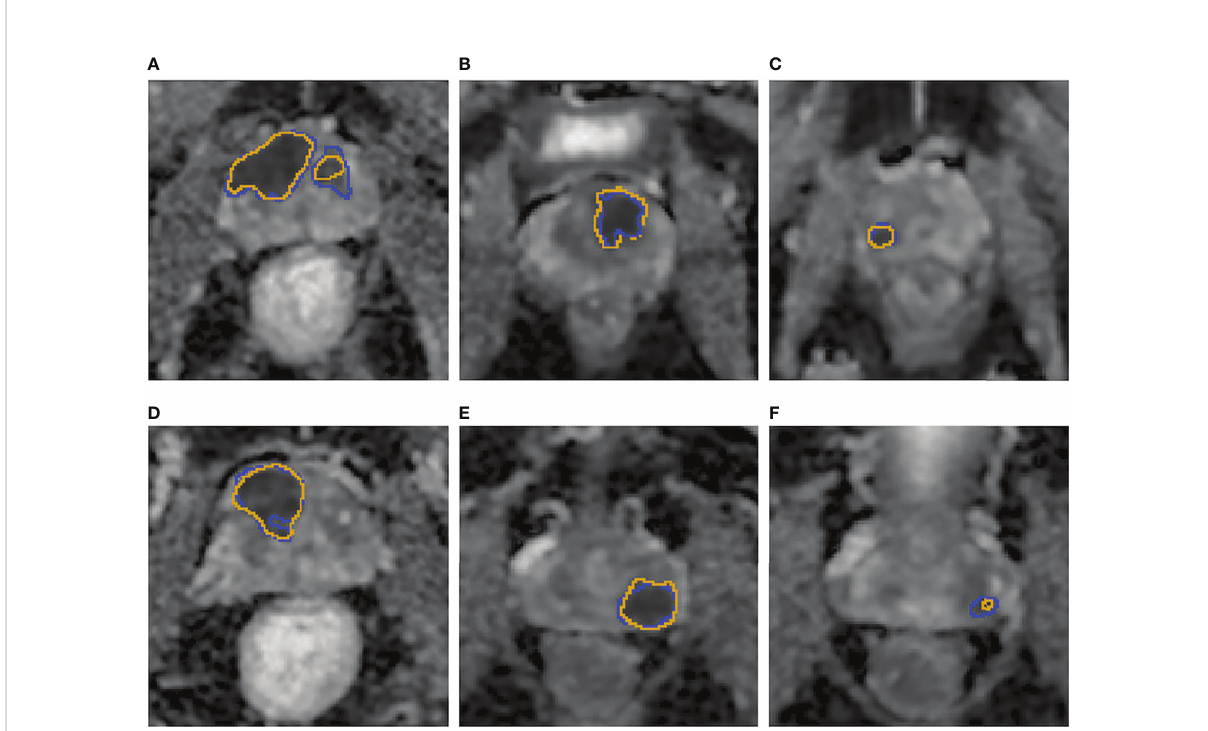
FIGURE 3 (A – F) Examples of the csPCa lesion segmentation performance of the biparametric model. The prediction results (A – F) , yellow line on the ADC map were highly consistent with the manual annotation (A – F) , blue line on ADC map by experienced urogenital radiologists according to pathological